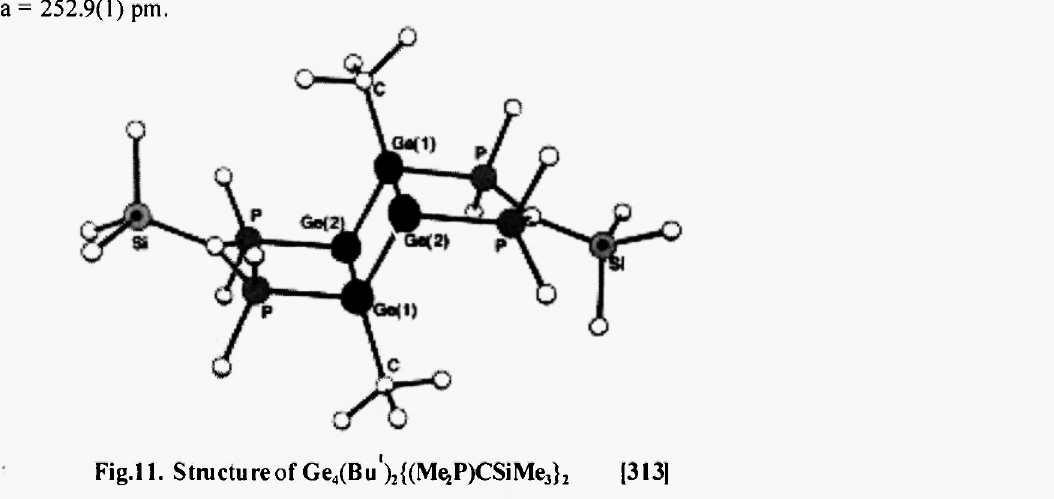
Fig.ll. StmctureofGe 4 (Bu') 2 {(M^P)CSiMe 3 } 2